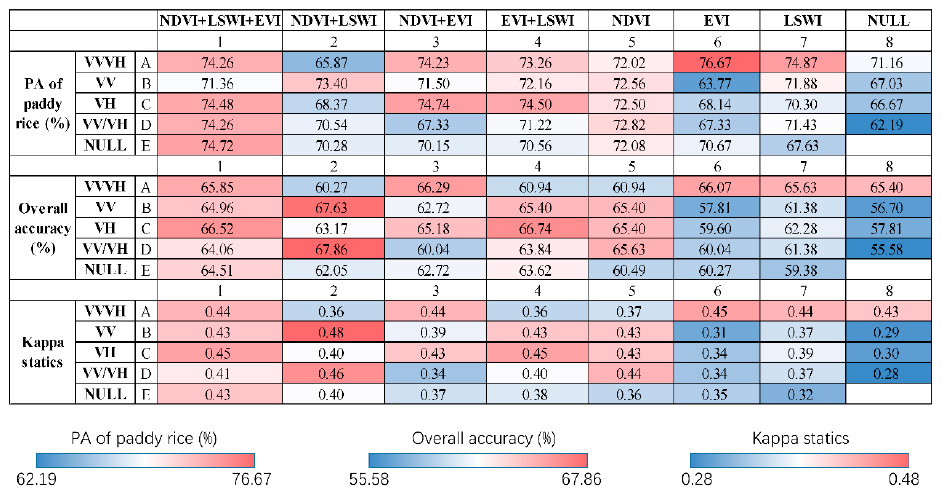
Figure 4. Classification accuracy results.